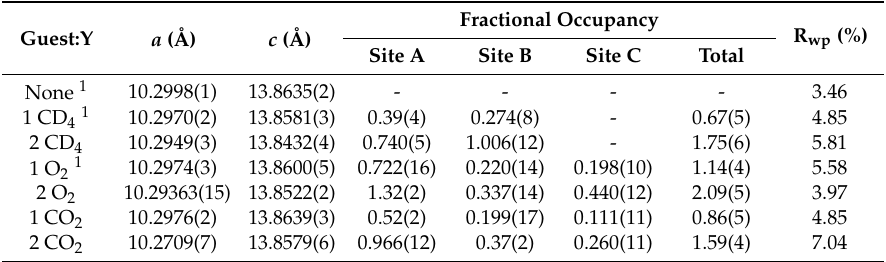
Table 2. Unit-cell parameters and site-occupancy factors determined using Rietveld analysis of NPD data for empty and guest-loaded